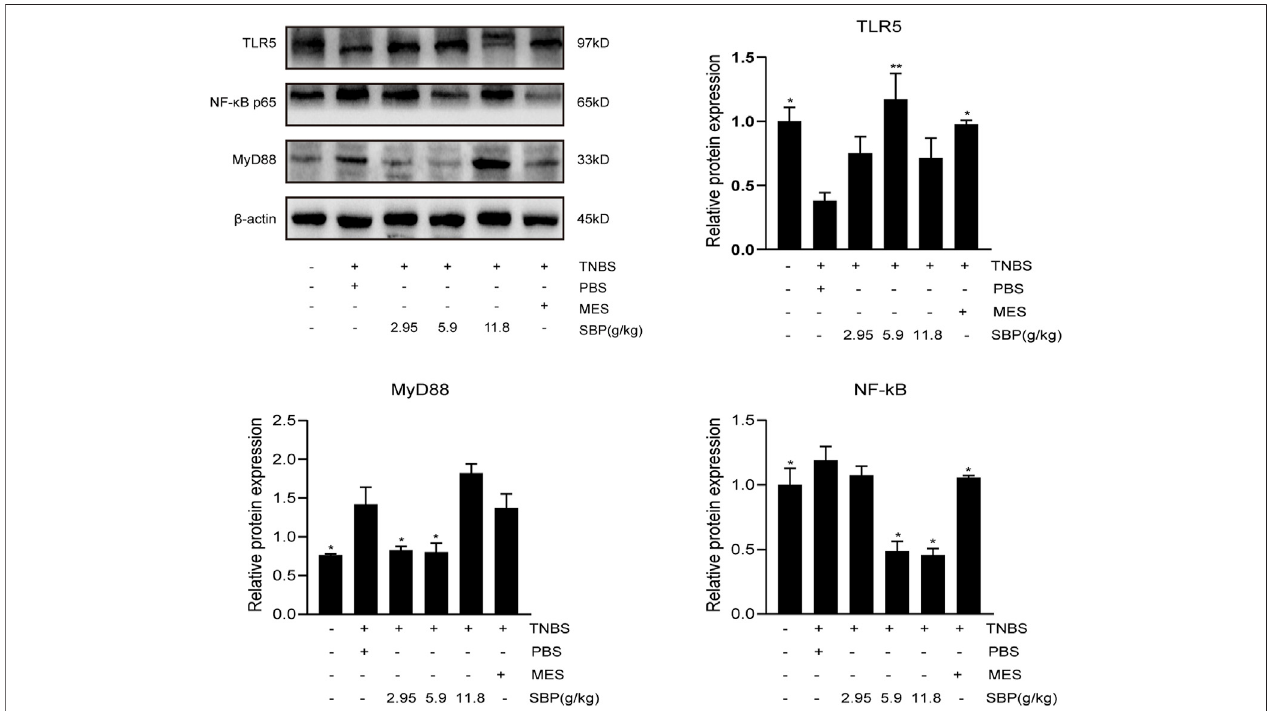
FIGURE 7 | Effects of SBP on the levels of key molecules involved in the TLR5/MyD88/NF- κ B signaling pathway in TNBS-induced colitis rats. The level of TLR5/ MyD88/NF- κ Bp65inthecolonictissueswereanalyzedusingwesternblot.vs.TNBS+PBSgroup, n =3rats/group,Datashownasmeans±SEM.* p < 0.05,** p < 0.01.